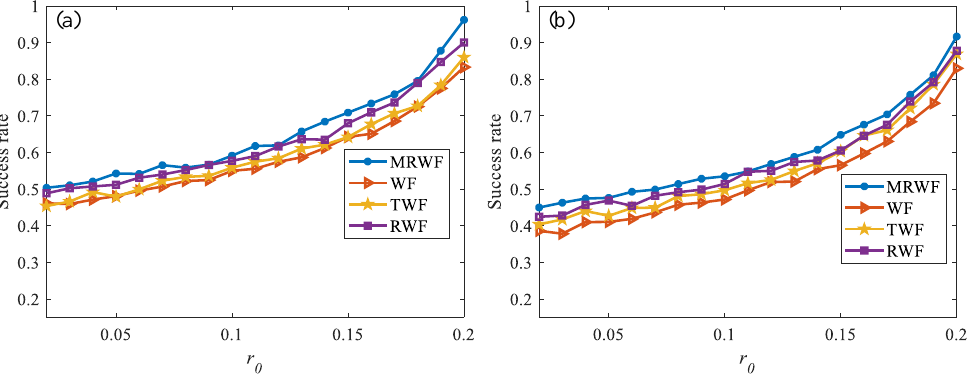
Figure 10. Comparison of success rates of different algorithms for recovery: ( a ) turbulence effects; ( b ) turbulence and pointing error effects. ( b ) turbulence and pointing error